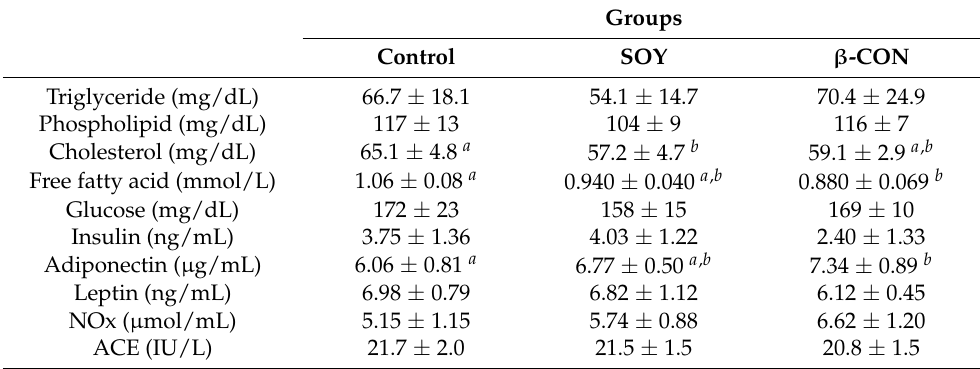
Table 2. Effect of dietary β -conglycinin on plasma concentrations of lipids, glucose, hormones, and factors influencing blood pressure in SHR.